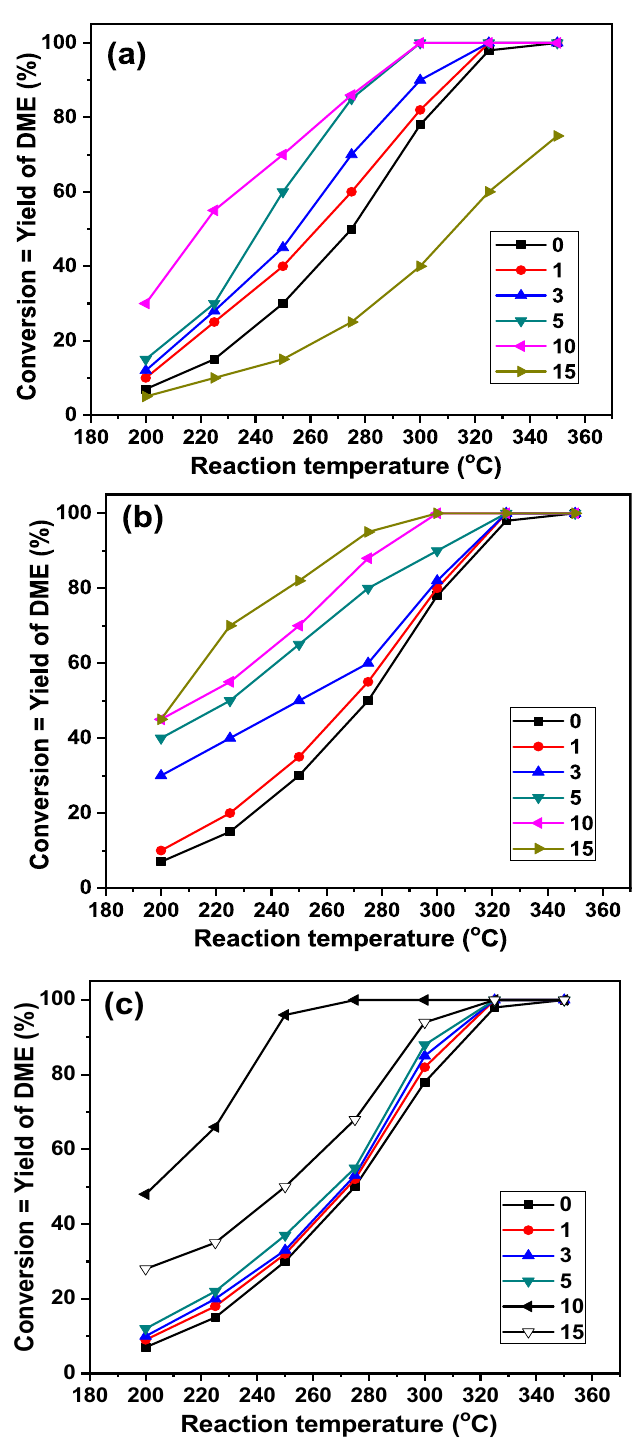
Figure 6. Catalytic dehydration of methanol into DME over kaolin and modified kaolin with different percentages of ( a ) H 2 SO 4 , ( b ) WO 3 , and ( c ) ZrO 2 calcined at 400 °C, at different reaction temperatures. Error bar =